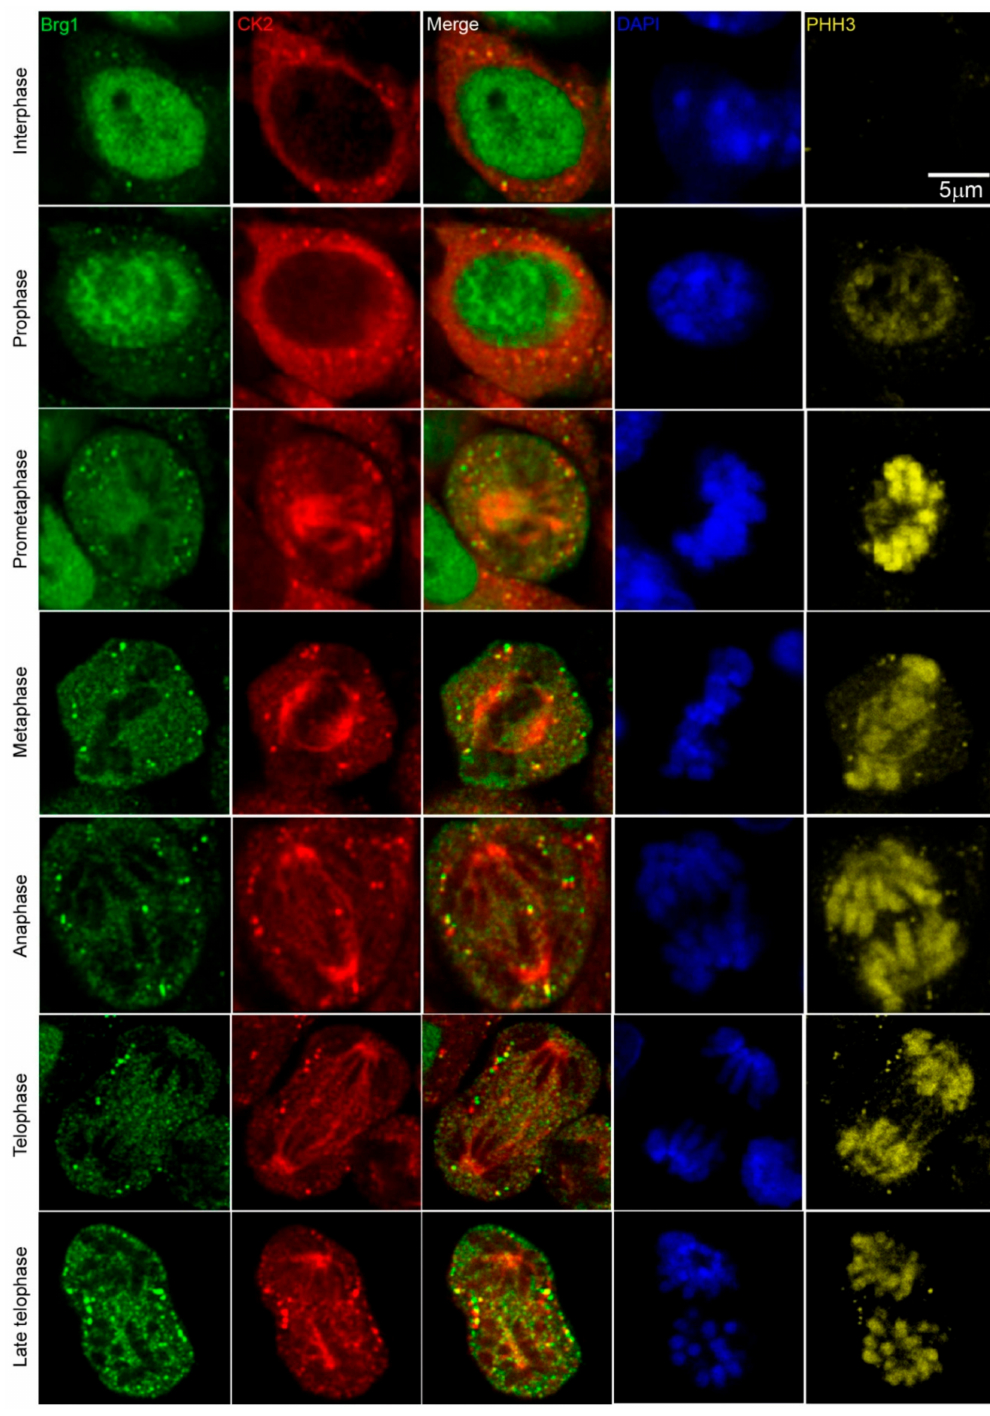
Figure 2. CK2 and Brg1 co-localize in mitotic primary myoblasts derived from mouse satellite cells. Representative confocal microscopy images from three independent biological replicates show the expression of Brg1 (green), CK2 (red), and phosphorylated histone H3 (PHH3, yellow) in proliferating primary myoblasts. The nuclei were stained with DAPI